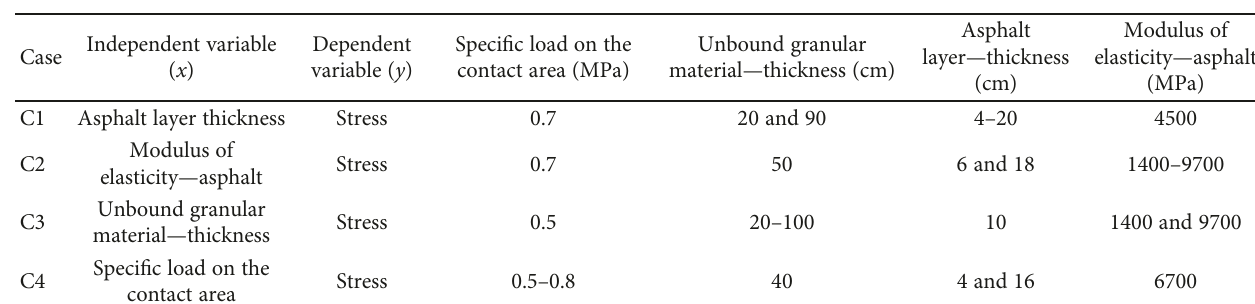
Figure 8: Results — case B. Table 2: Input values — case C.